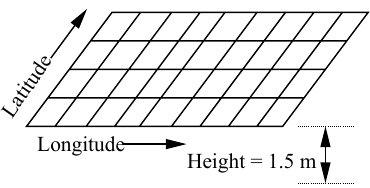
Figure 4. An example domain defined by three dimensions, one of which is single valued